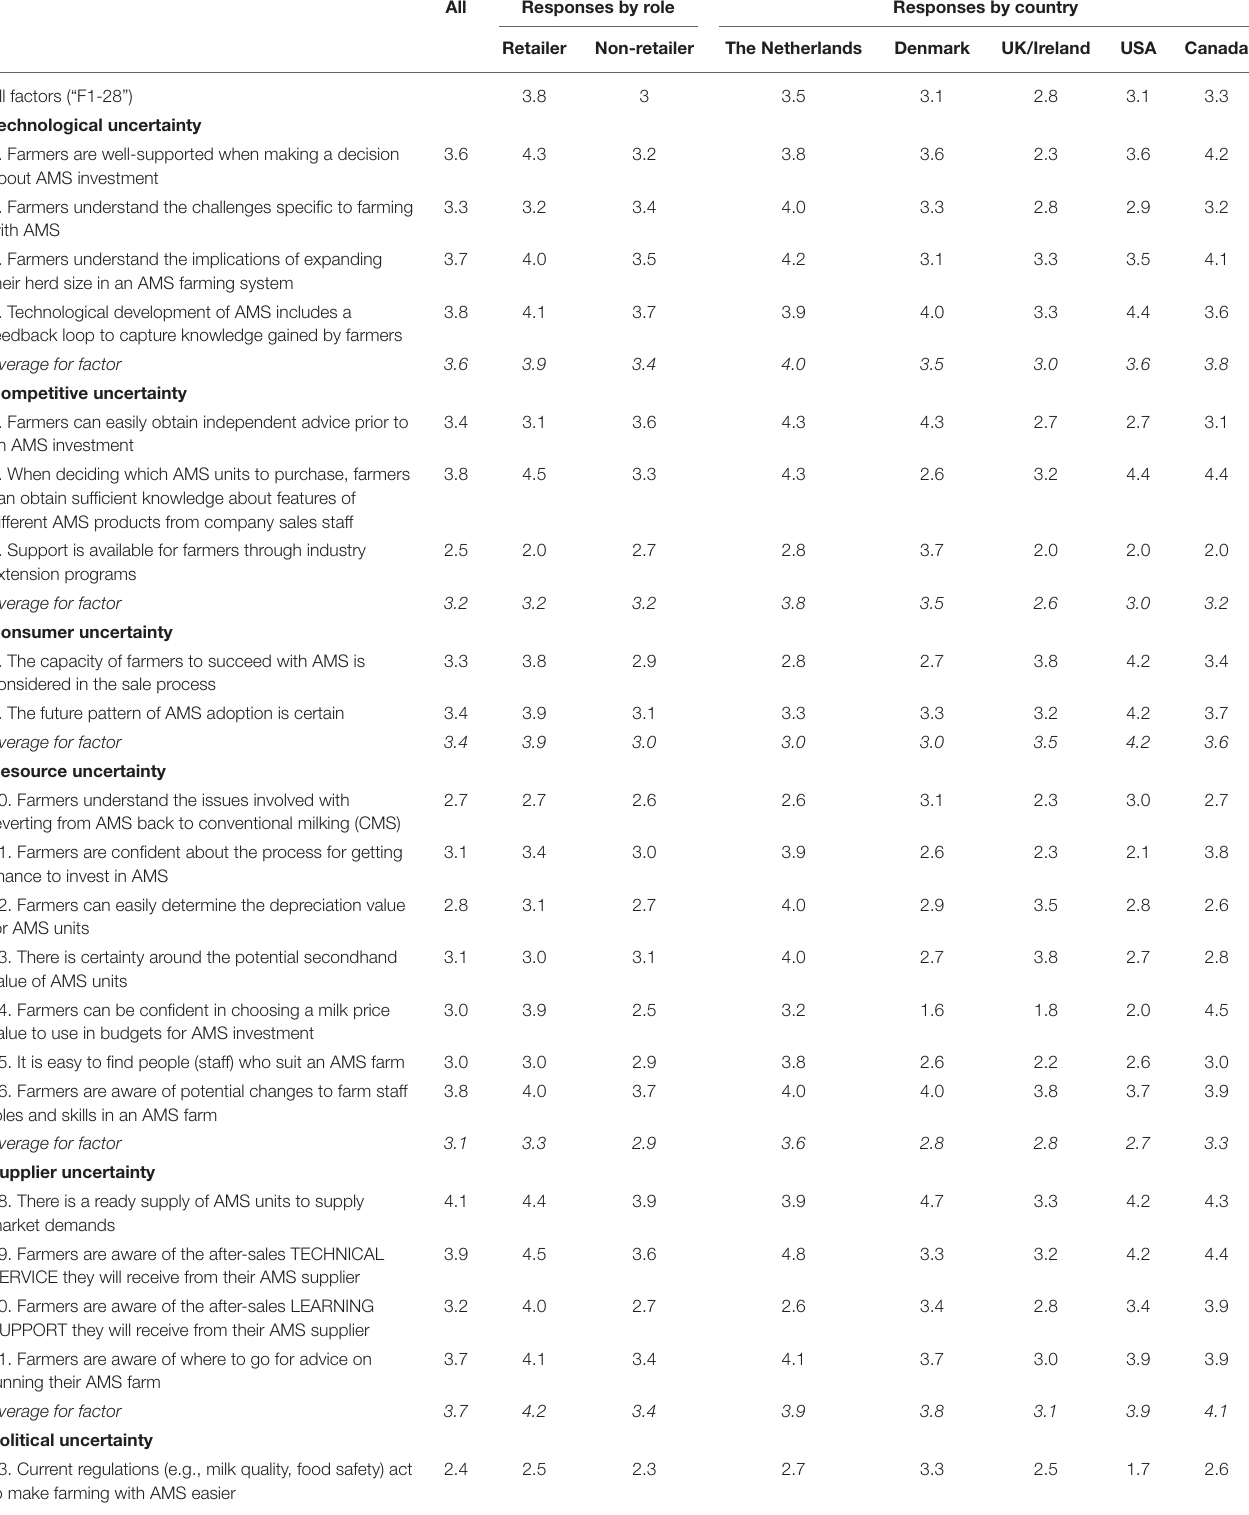
TABLE 6 | Average responses to questions for the six innovation uncertainty categories, by role and country (scale of 1–5 where 1 = strongly disagree, 5 = strongly